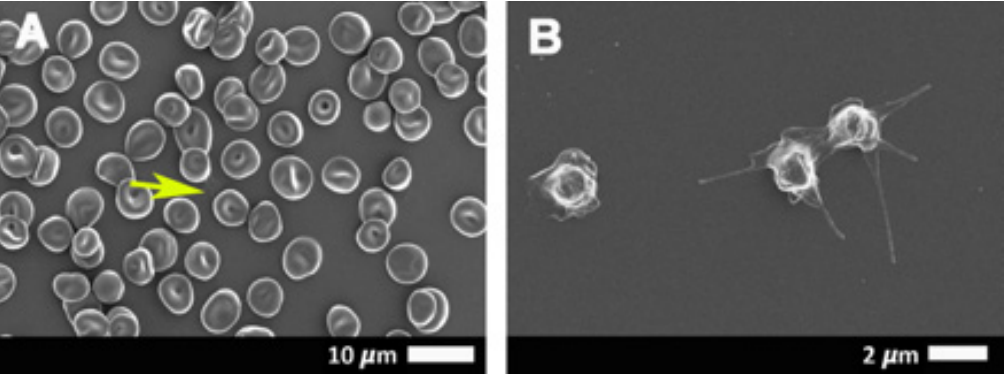
Figure 2. Representative scanning electron micrographs of the erythrocytes ( A ) and platelet ultrastructure ( B ) seen in healthy individuals. Yellow arrow points to a platelet in a whole-blood smear.